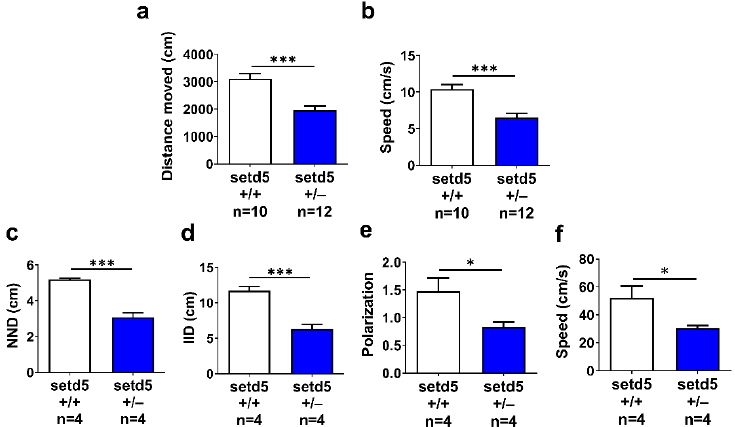
Figure 5. setd5 haploinsufficiency alters locomotor activity and induces an anxiety-like shoaling be- havior in adult mutant zebrafish. ( a ) Distance moved and ( b ) speed (cm/s) of setd5 +/+ and setd5 +/ − adult fish evaluated during a 5-min-long open field test.; n = number of fishes analyzed. ( c ) Nearest Neighbor Distance (NND), ( d ) Inter-Individual Distance (IID), ( e ) polarization and ( f ) mean speed of fish groups constituted by 4 setd5 +/+ or setd5 +/ − adults, evaluated by a shoaling test. ( a – f ) n = number of group of fish analyzed. Data are expressed as mean ± SEM. Statistical analysis was per- formed by Student’s t -test. * p < 0.05; *** p < 0.001.